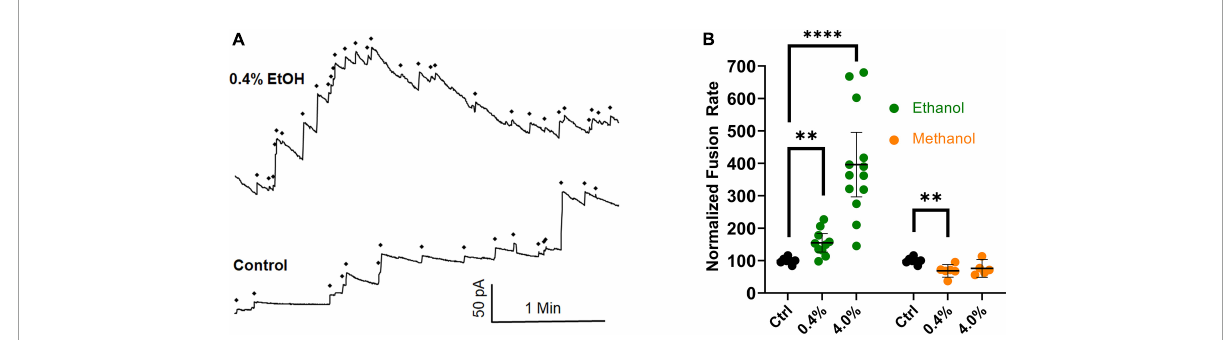
FIGURE6 Ethanol (0.4%), increases fusion rates in the protein-free fusion assay over controls. In this assay, an osmotic gradient, not SNARE proteins, is used to drive fusion of liposomes with a planar lipid membrane. (A) The control had 17 fusion events and the 0.4% ethanol had 30 fusion events during the 3.5 min segments shown. Each fusion event is marked with a (cid:7) and is indicated as an abrupt increase in current across the membrane which is voltage clamped at 60 mV. (B) Shows the averaged fusion rates of many experiments in response to ethanol (green) and methanol (orange). Error bars are 95% confidence intervals. ∗∗ p < 0.05 and ∗∗∗∗ p < 0.0001 using two-tailed student’s t -test n ≥ 5.